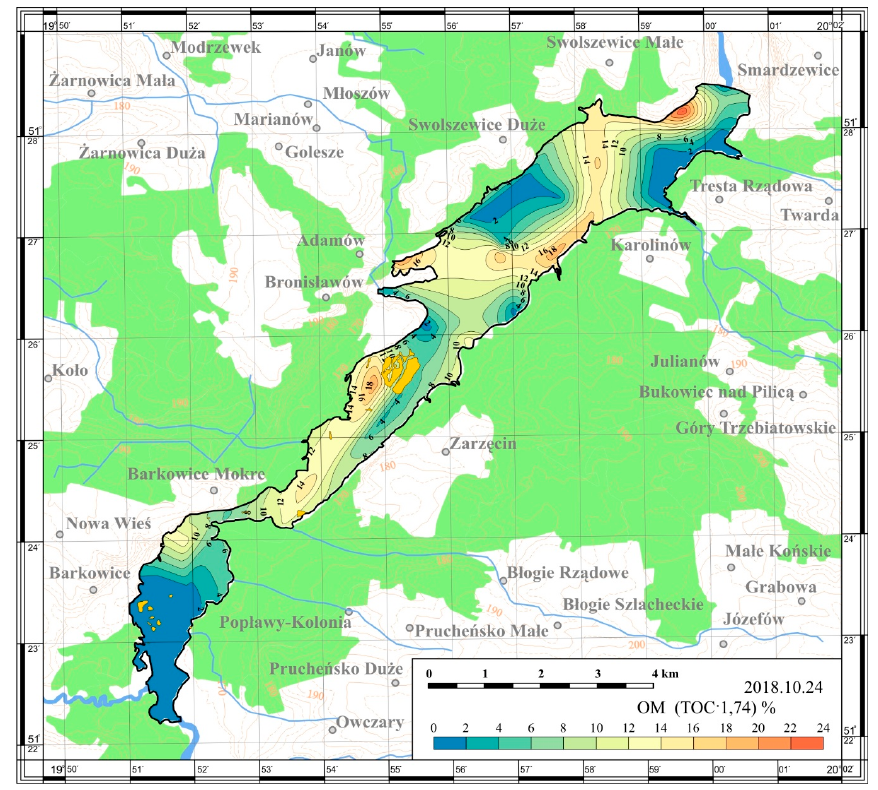
Figure 8. Spatial distribution of organic matter content in bottom sediments of the Sulejów Reservoir.